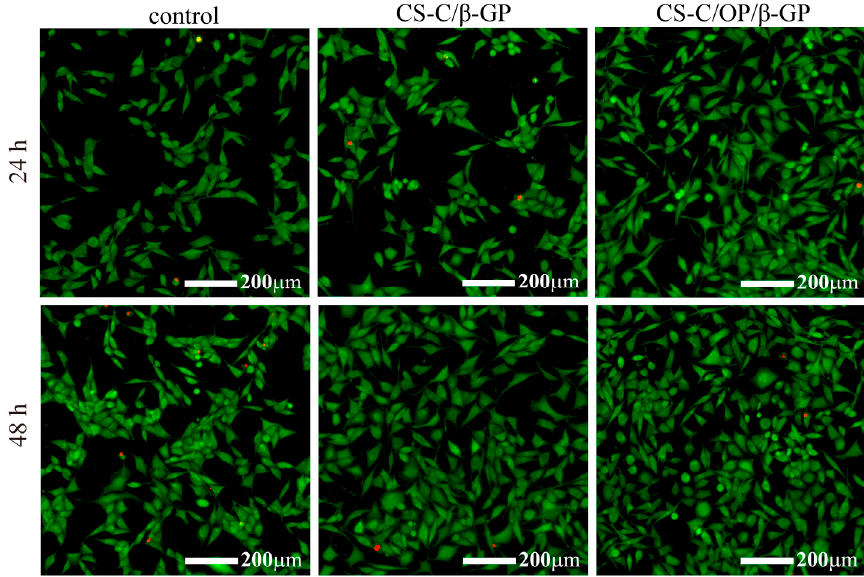
Figure 8. Calcein-AM / PI double staining for L929 cells.